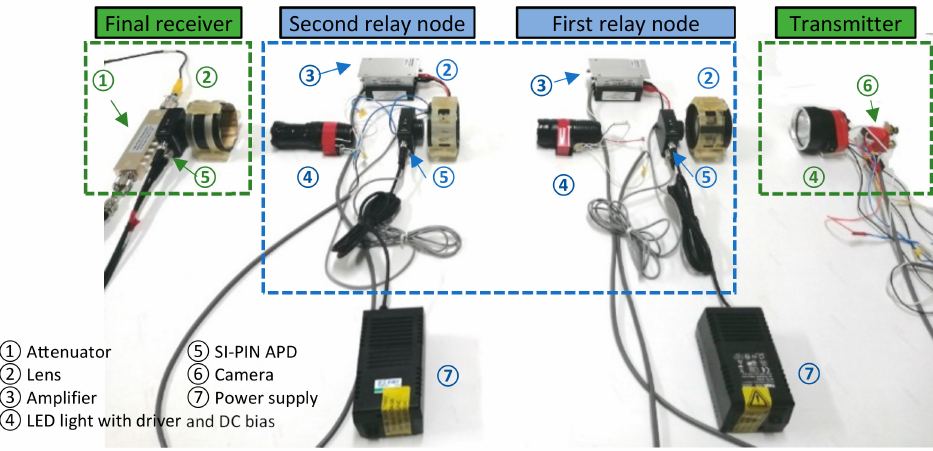
Figure 2. Entire architecture of AISRT